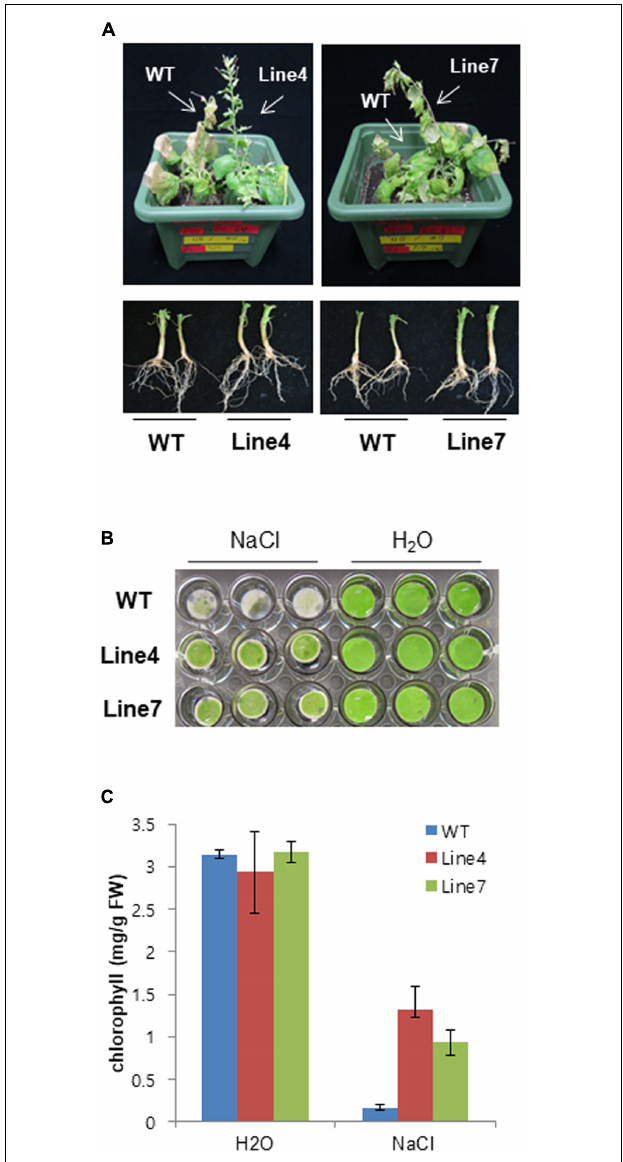
FIGURE 3 | Effects of sysr1 overexpression on salt tolerance during the adult stage. (A) Phenotype of WT and transgenic plants watered with NaCl solution (from 100 to 300 mM) for 4 weeks. (B) Representative image depicting phenotypic differences between WT and transgenic leaf disks. Leaves of 4-week-old WT and transgenic plants were cut into leaf disks (0.8 cm diameter) and floated on H 2 O or 300 mM NaCl. Leaf disks were incubated for 5 days at 25 ◦ C under a 16-h:8-h dark photoperiod. (C) Chlorophyll contents of leaf disks from WT and transgenic plants treated with H 2 O or 300 mM NaCl. Damages caused by salt stress are indicated by the extent of leaf-tissue bleaching after 5 days ( n =